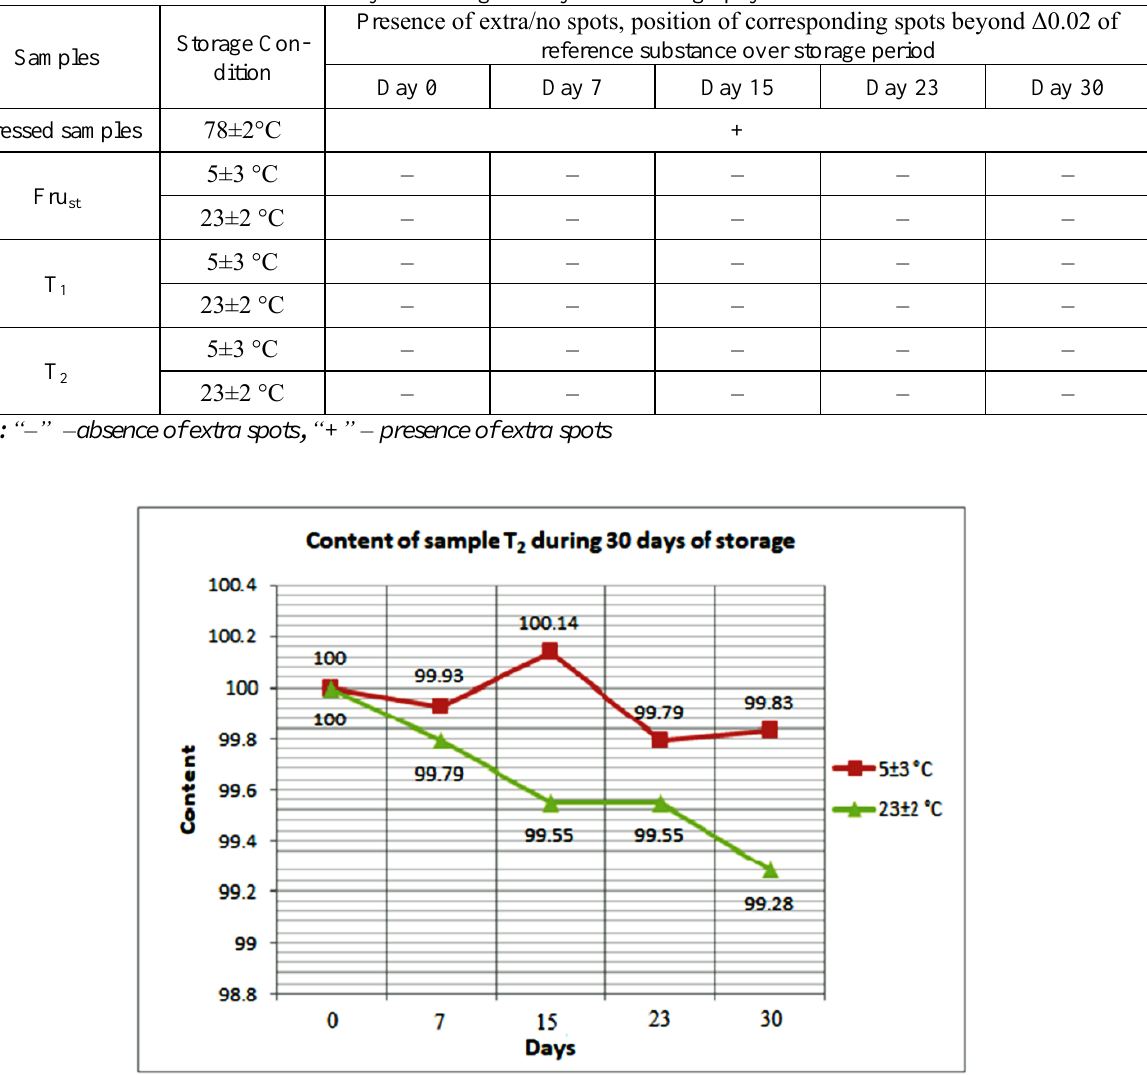
Fig 3. Graphic representation of furosemide content (%) in sample T stored in the dark for a month. (n=5). Plot shows 2, the assayed values (%) of furosemide (y-axis) in the syrup made from crushed commercial tablets to understand the rate and degree of loss in its content over a specific period of time (days: x-axis). * – P<0.05 compared with control